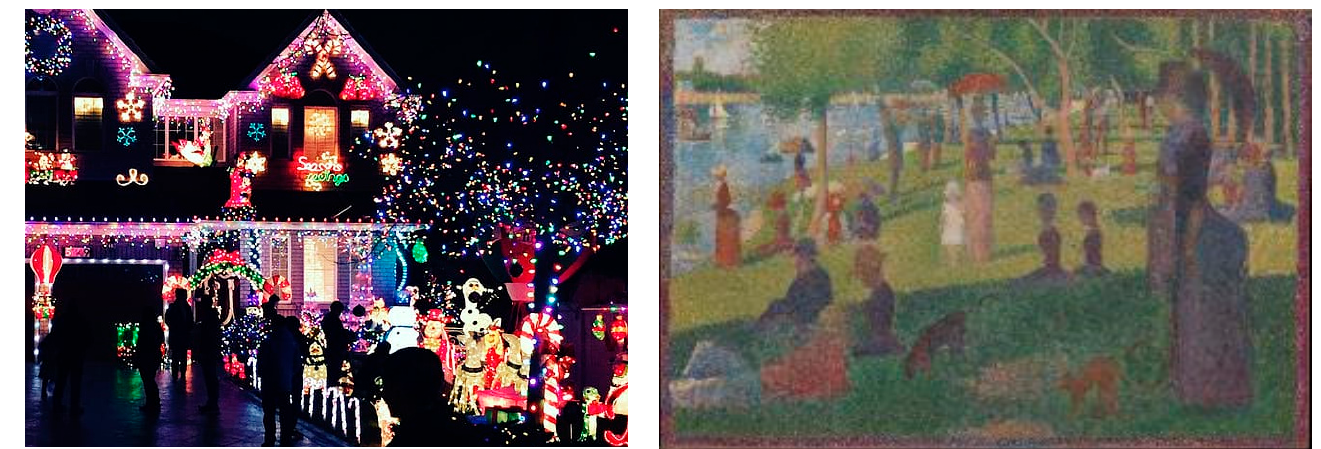
Figure 4. Lighting a façade ( left ) using a specific art style ( right ) [71,72].